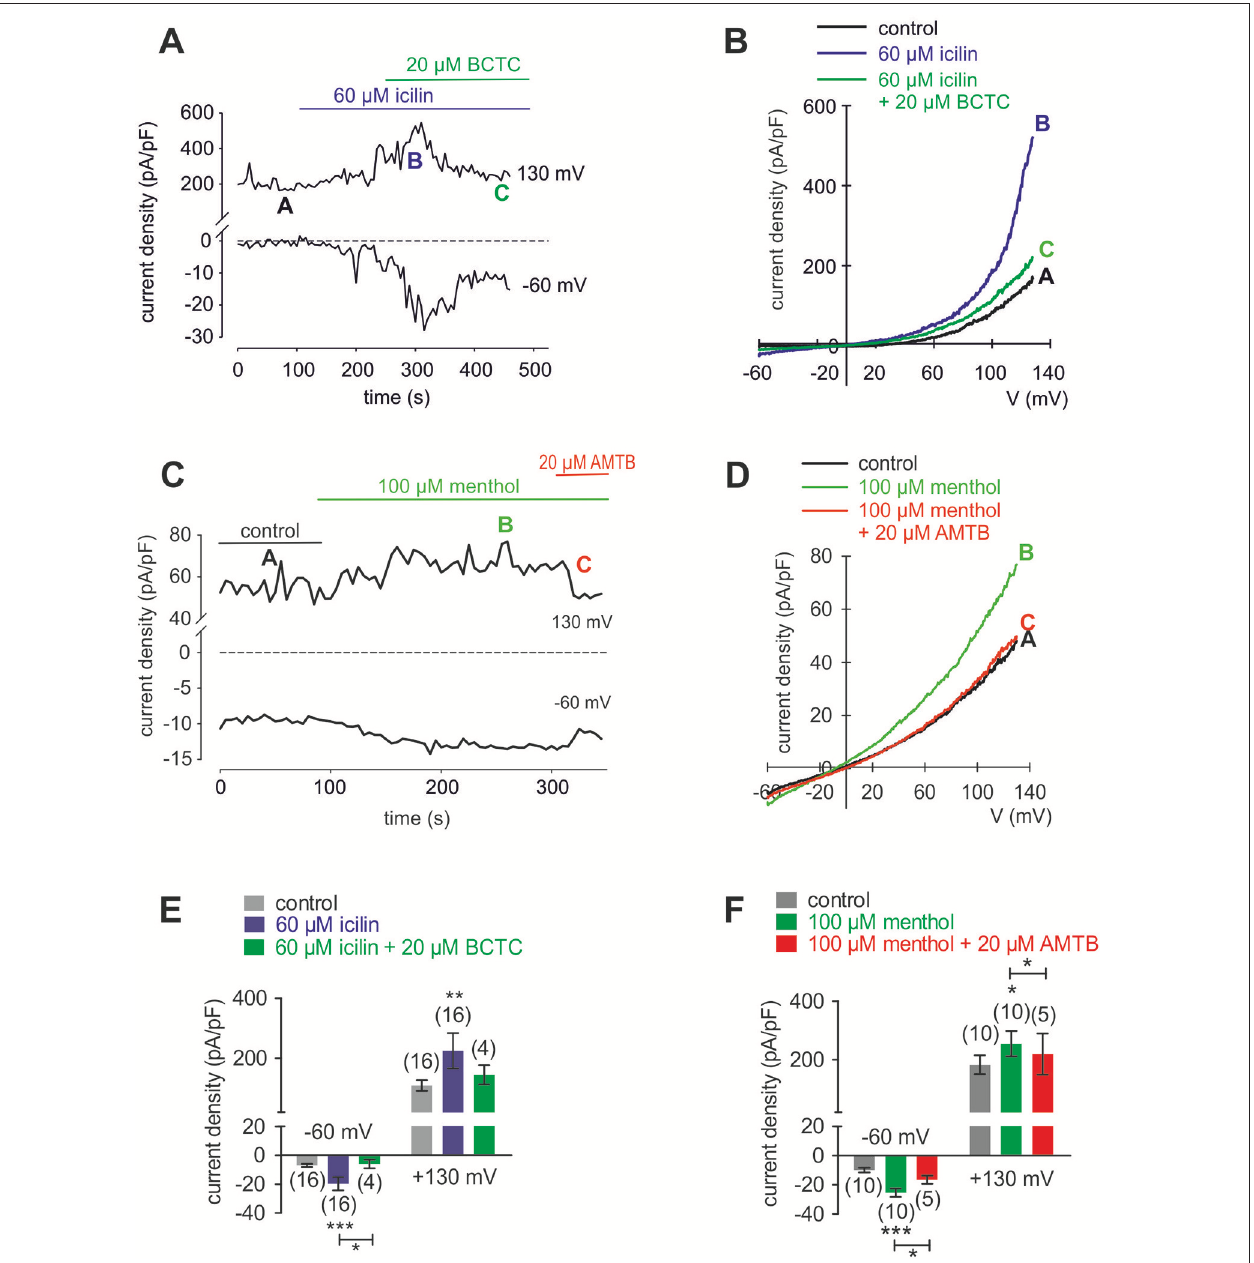
FIGURE 9 | Menthol and icilin activated whole-cell currents in HCK. (A) Time course recording showing the current increases induced by icilin (60 µ M) and declines after application of 20 µ M BCTC. (B) Original traces of icilin-induced current responses to voltage ramps. Current densities are shown before application (labeled as A), during application of 60 µ M icilin (labeled as B), and after addition of 20 µ M BCTC (labeled as C). Current densities as function of voltage were derived from the traces shown in (A) . (C) Time course recording showing the current increases induced by menthol (100 µ M) and declines after application of 20 µ M AMTB. (D) Original traces of menthol-induced current responses to voltage ramps. Current densities are shown before application (labeled as A), during application of 100 µ M menthol (labeled as B), and after addition of 20 µ M AMTB (labeled as C). Current densities as function of voltage were derived from the traces shown in (C) . (E) Summary of patch-clamp experiments with icilin and BCTC. The asterisks (*) indicate statistically significant differences between in- and outward whole-cell currents with and without icilin ( n = 16; p < 0.001; paired tested) and significant difference of inward currents between icilin with and without BCTC ( n = 4; p < 0.05; unpaired tested). (F) Summary of patch-clamp experiments with menthol and AMTB. The asterisks (*) indicate statistically significant differences of in- and outward whole-cell currents with and without menthol ( n = 10; p < 0.001; paired tested) and significant difference of inward currents between menthol with and without AMTB ( n = 5; p < 0.05; paired